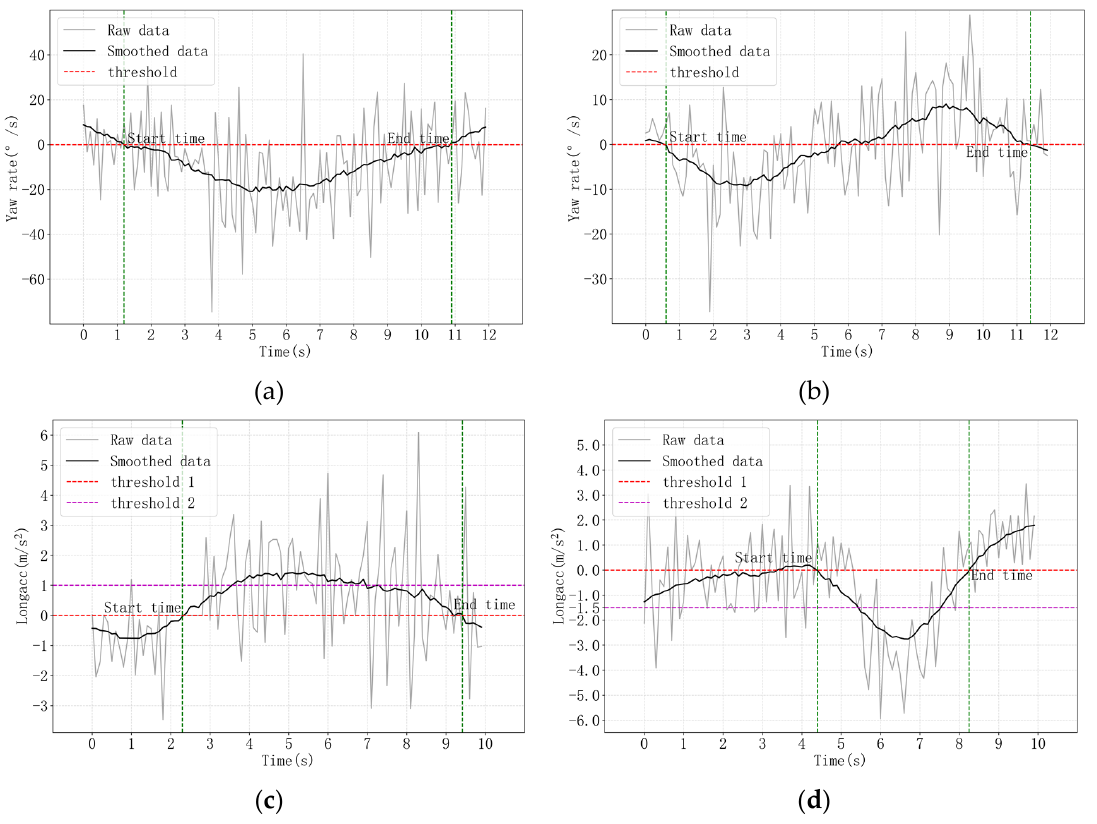
Figure 3. The principle of driving behaviors labeled by thresholds. ( a ) Turning behavior, ( b ) Lane- change behavior, ( c ) Acceleration behavior, ( d ) Deceleration behavior.